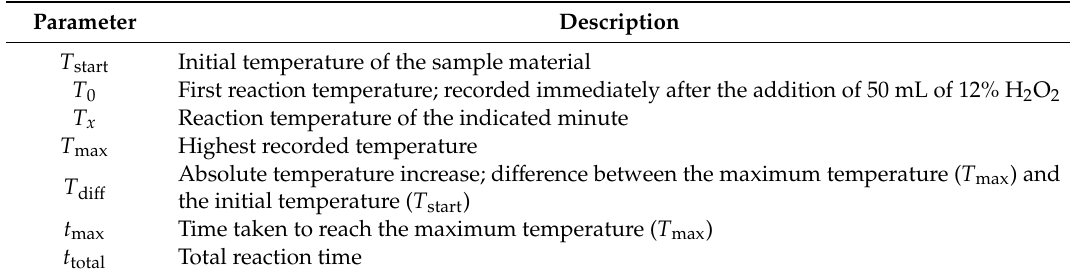
Table 1. List of parameters recorded during IR thermography